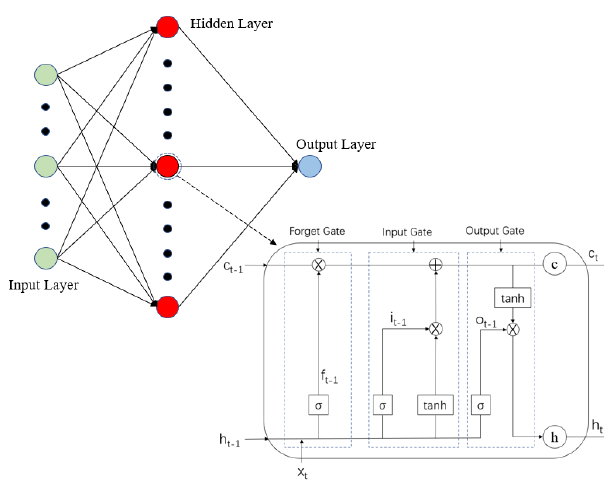
Figure 1. LSTM model structure diagram.